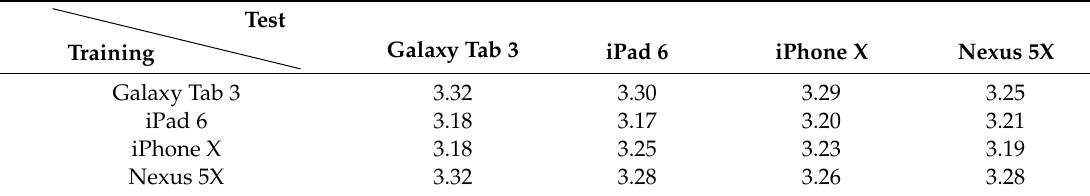
Table 8. HTER results for cross-device scenarios of PR-FSAD using ResNet-18 (unit: %). Test Galaxy Tab Training